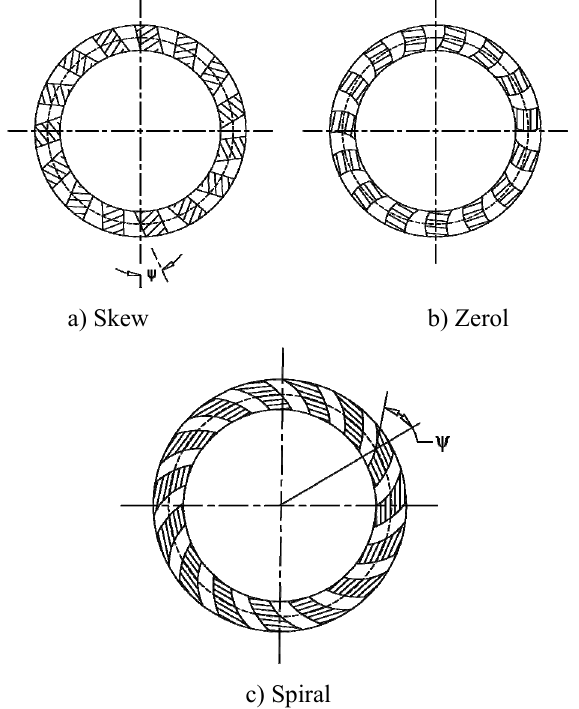
Fig. 1: Types of helical bevel